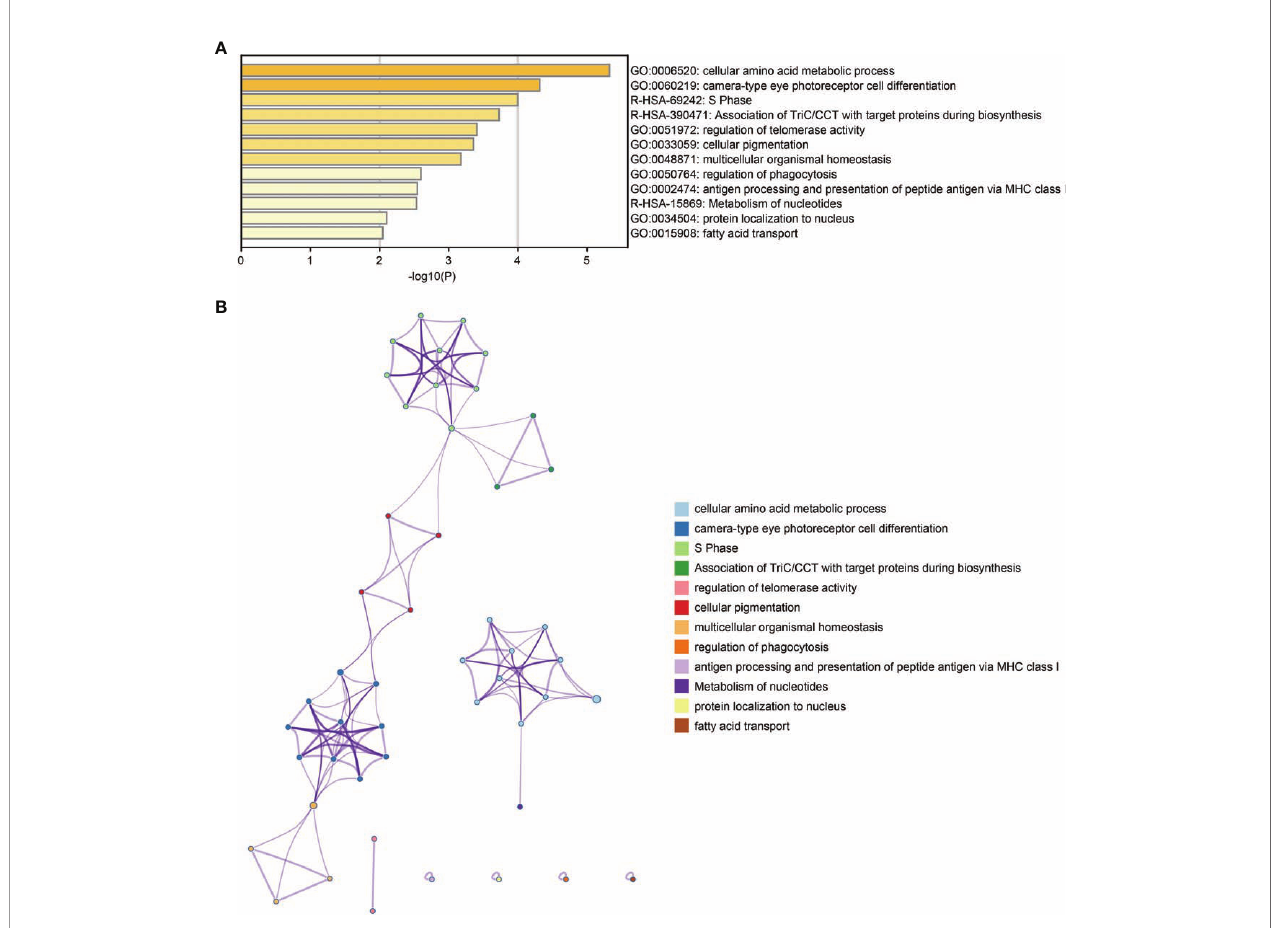
FIGURE 2 | Functional enrichment analysis of DEGs. (A) Bar plot of DEGs functional enrichment terms. (B) Network relationship plots among all